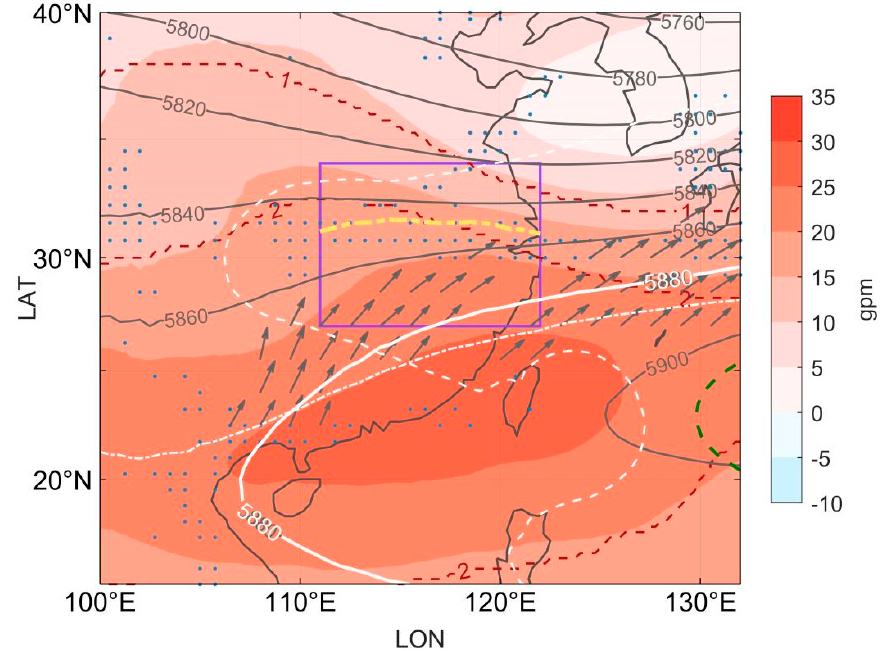
Figure 2. The mean geopotential height in June–July 2020 (gray contour, unit: gpm), its deviation from the climate mean in 1980–2019 (shading), the level of standard deviations (red dashed contours), and the mean horizontal wind at 850 hPa exceeding 8 m s − 1 . Defined by 5880 gpm at 500 hPa, the white-solid line denotes the mean ridge axis of the subtropical high during June–July 2020, the white dashed and dash-dotted lines mark the location of the WPSH in the onset (1 June) and the end day (2 August) of the 2020 Meiyu season, and the green dashed line denotes the climate mean location of the WPSH in 1980–2019. The blue dots mark the areas with no less than two standard deviations of the total rainfall in June–July 2020 from the climate mean in 1980–2019. The yellow dashed lines denote the location of a mean Meiyu front, determined by the maximum gradient of the equivalent potential temperature at 850 hPa. The purple rectangle represents the study area used for this study, i.e., 27° to 34° N in latitude and 111° to 120° E in longitude.